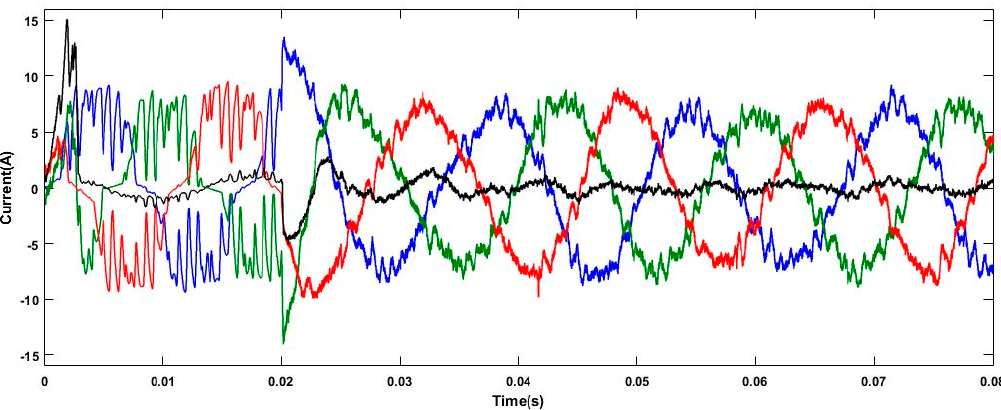
Figure 11. Compensation result with the traditional p-q method for case 2.